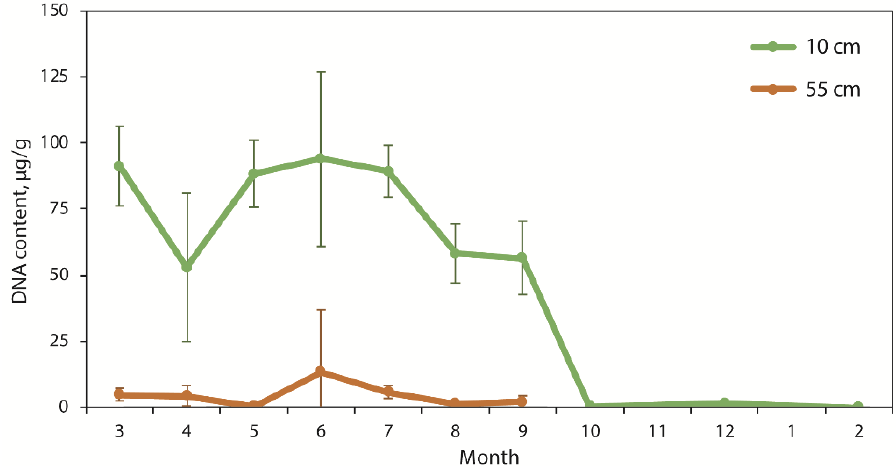
Figure 2. Seasonal dynamics of DNA yields. the sampling depth for upper organic horizon is 10 cm, the sampling depth for lower mineral horizon is 55 cm.